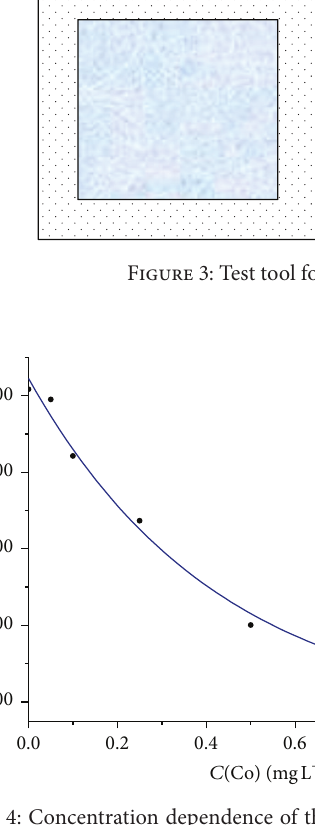
Figure 4: Concentration dependence of the color coordinate 𝑅 of the colored spots measured by digital portable reflectometer for determination of Co(II) by the reaction of pyrocatechin oxidation.